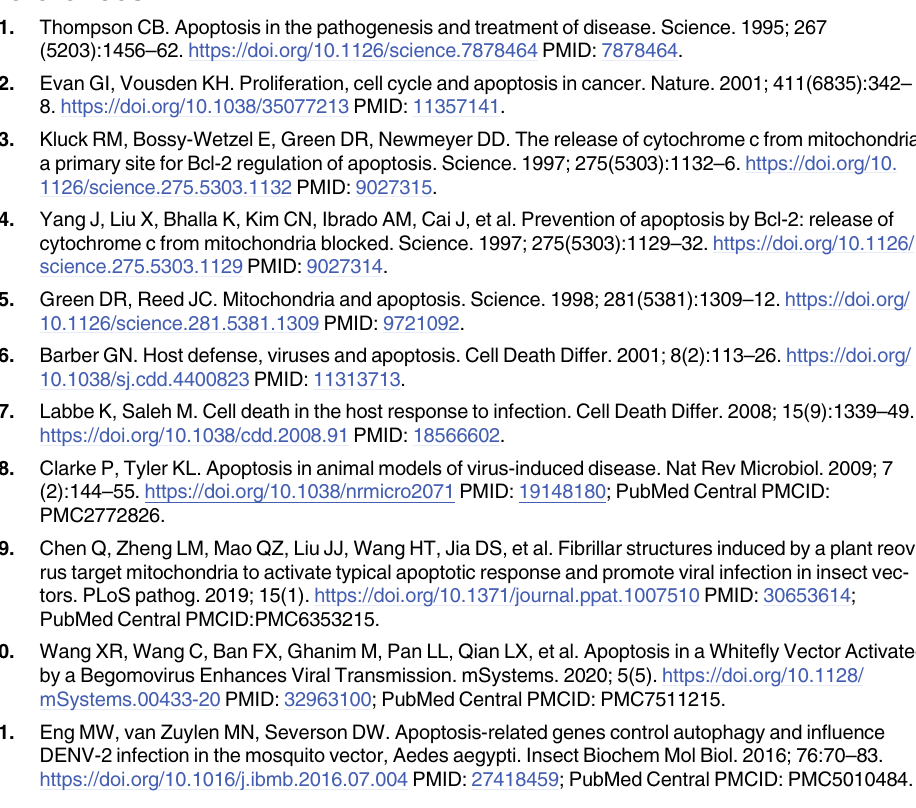
S2 Table. The detailed information of commercial antibodies used in this